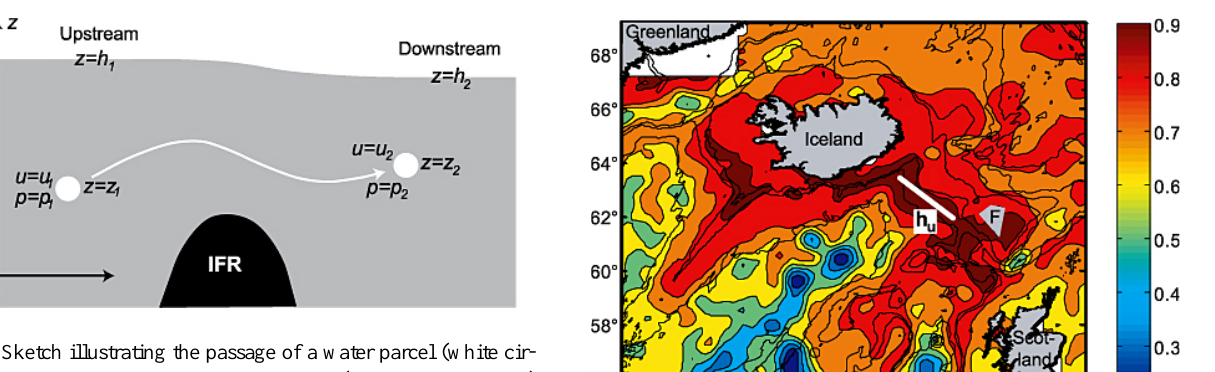
Fig. 6. Sketch illustrating the passage of a water parcel (white cir- cle) across the IFR along an arbitrary path (curved white arrow) with u representing speed, p representing pressure, and z represent- ing height of the parcel above a geopotential surface (Gill, 1982).